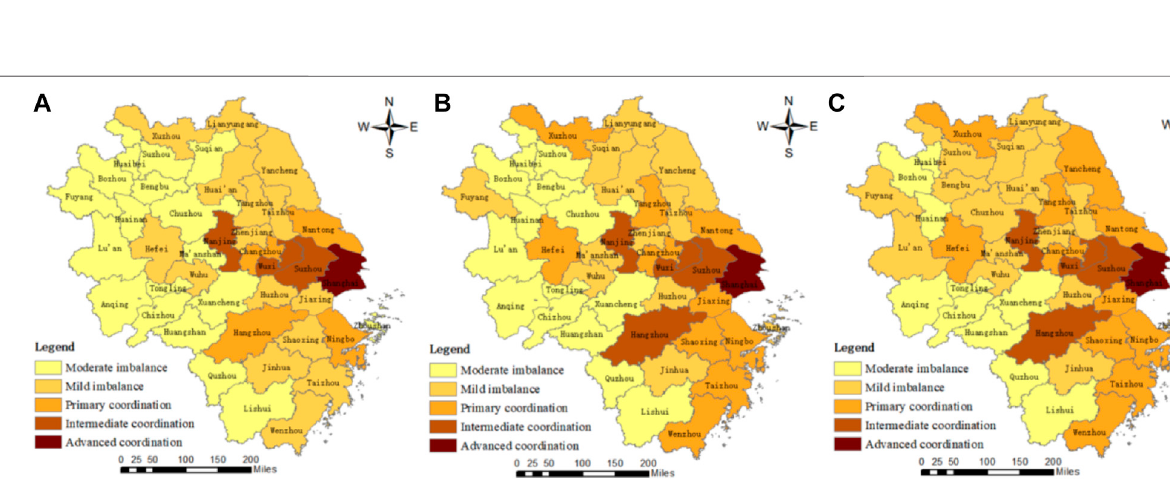
Frontiers in Environmental Science |